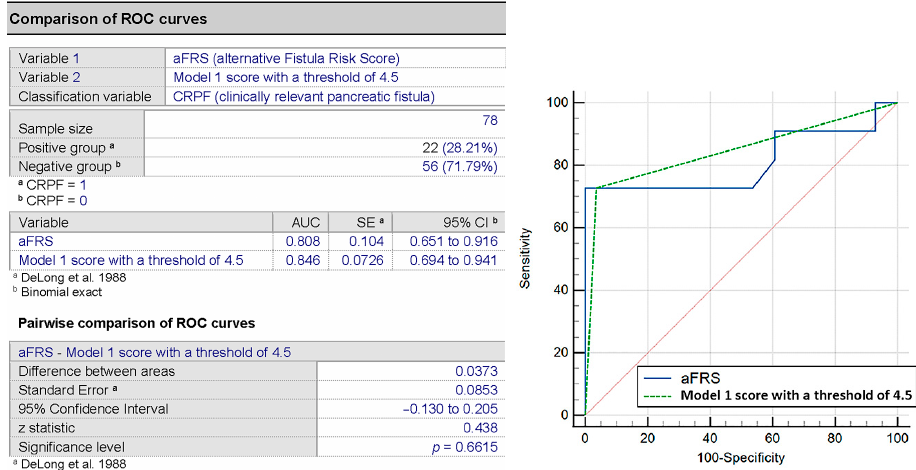
Figure 4. AUC comparison of aFRS and the score in Model 1 for the prediction of CRPF. Model 2 (using ERPV, MPD and UDL).